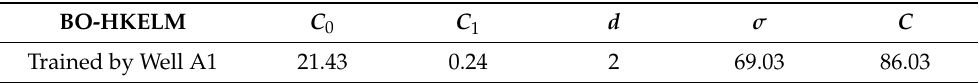
Trained by Well A1